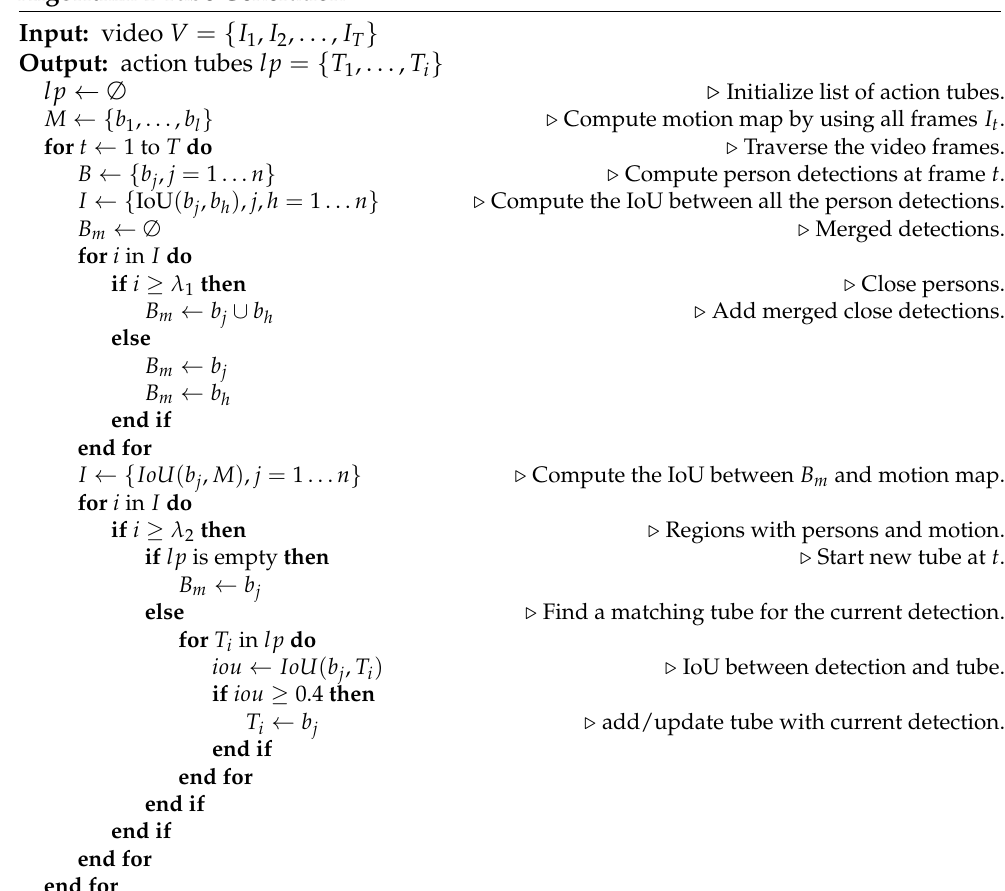
Algorithm 1 Tube